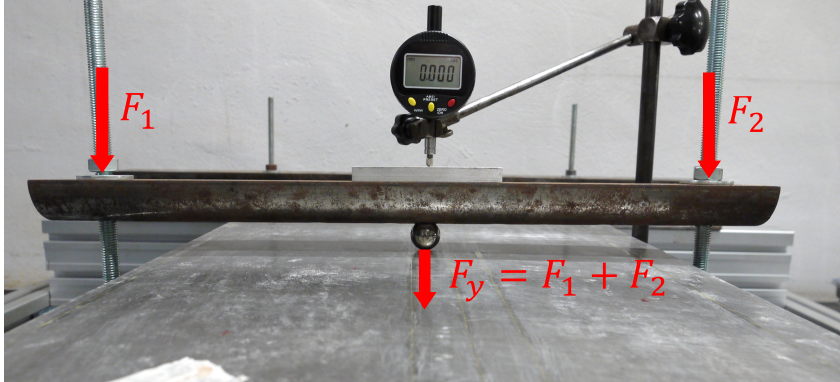
Figure 5. Detail of the load application system.